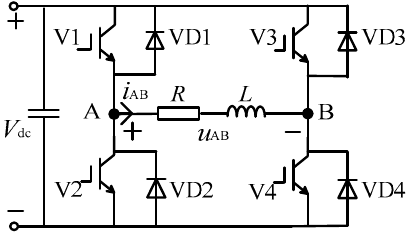
Figure 3. Topology of single-phase voltage source inverter. Figure 2. The PWM pulse is located at ( a ) the center of switching cycle; ( b ) the back of switching cycle.